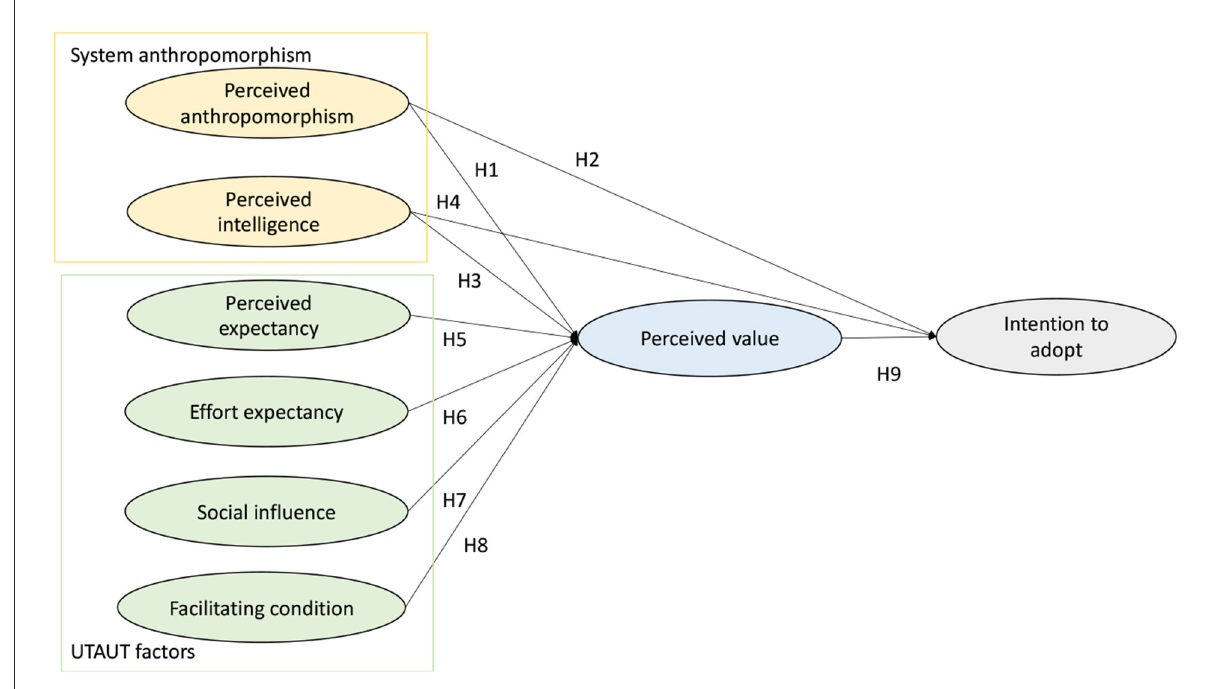
FIGURE1 Research